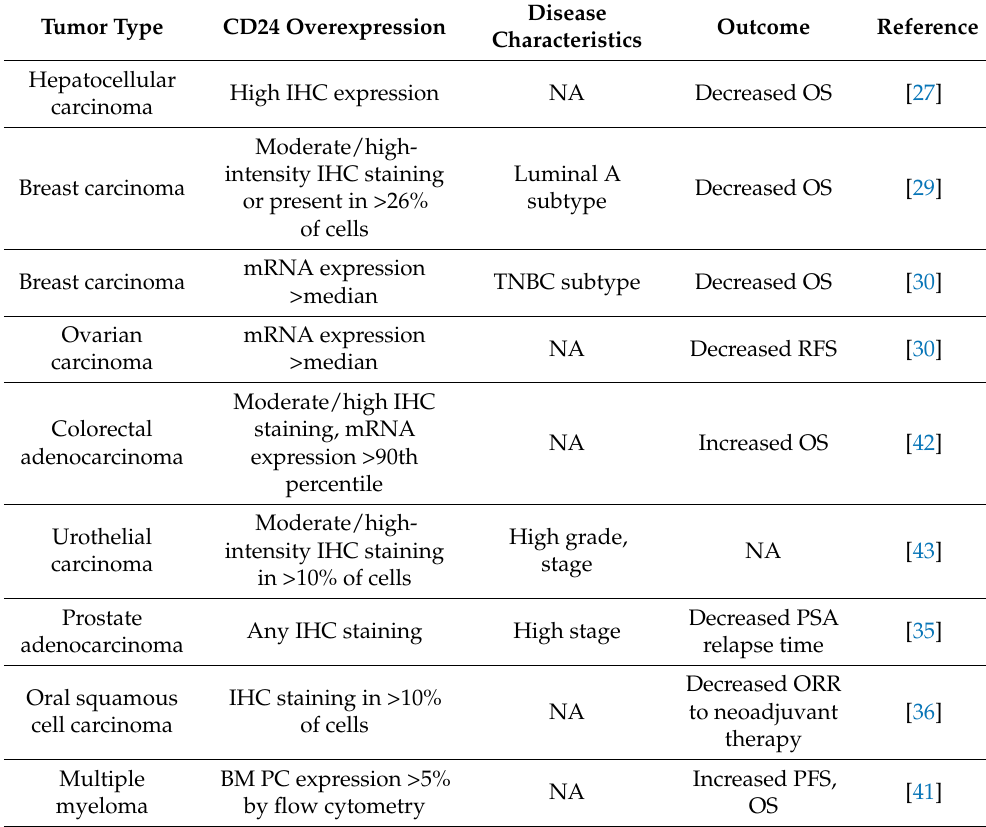
Table 1. Association between CD24 overexpression and disease features across different tumor